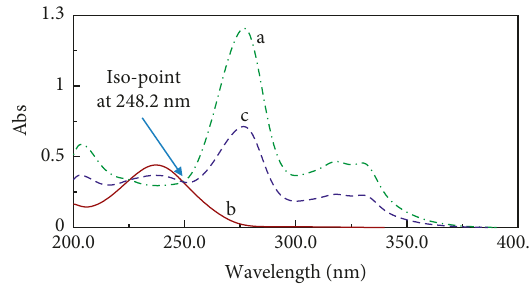
Figure 2: Zero-order spectra of (a) (CIP) (10.0 μ g/mL), (b) FLU (10.0 μ g/mL), and (c) a mixture containing 5.0 μ g/ml of (CIP) and FLU showing the isoabsorptive point.